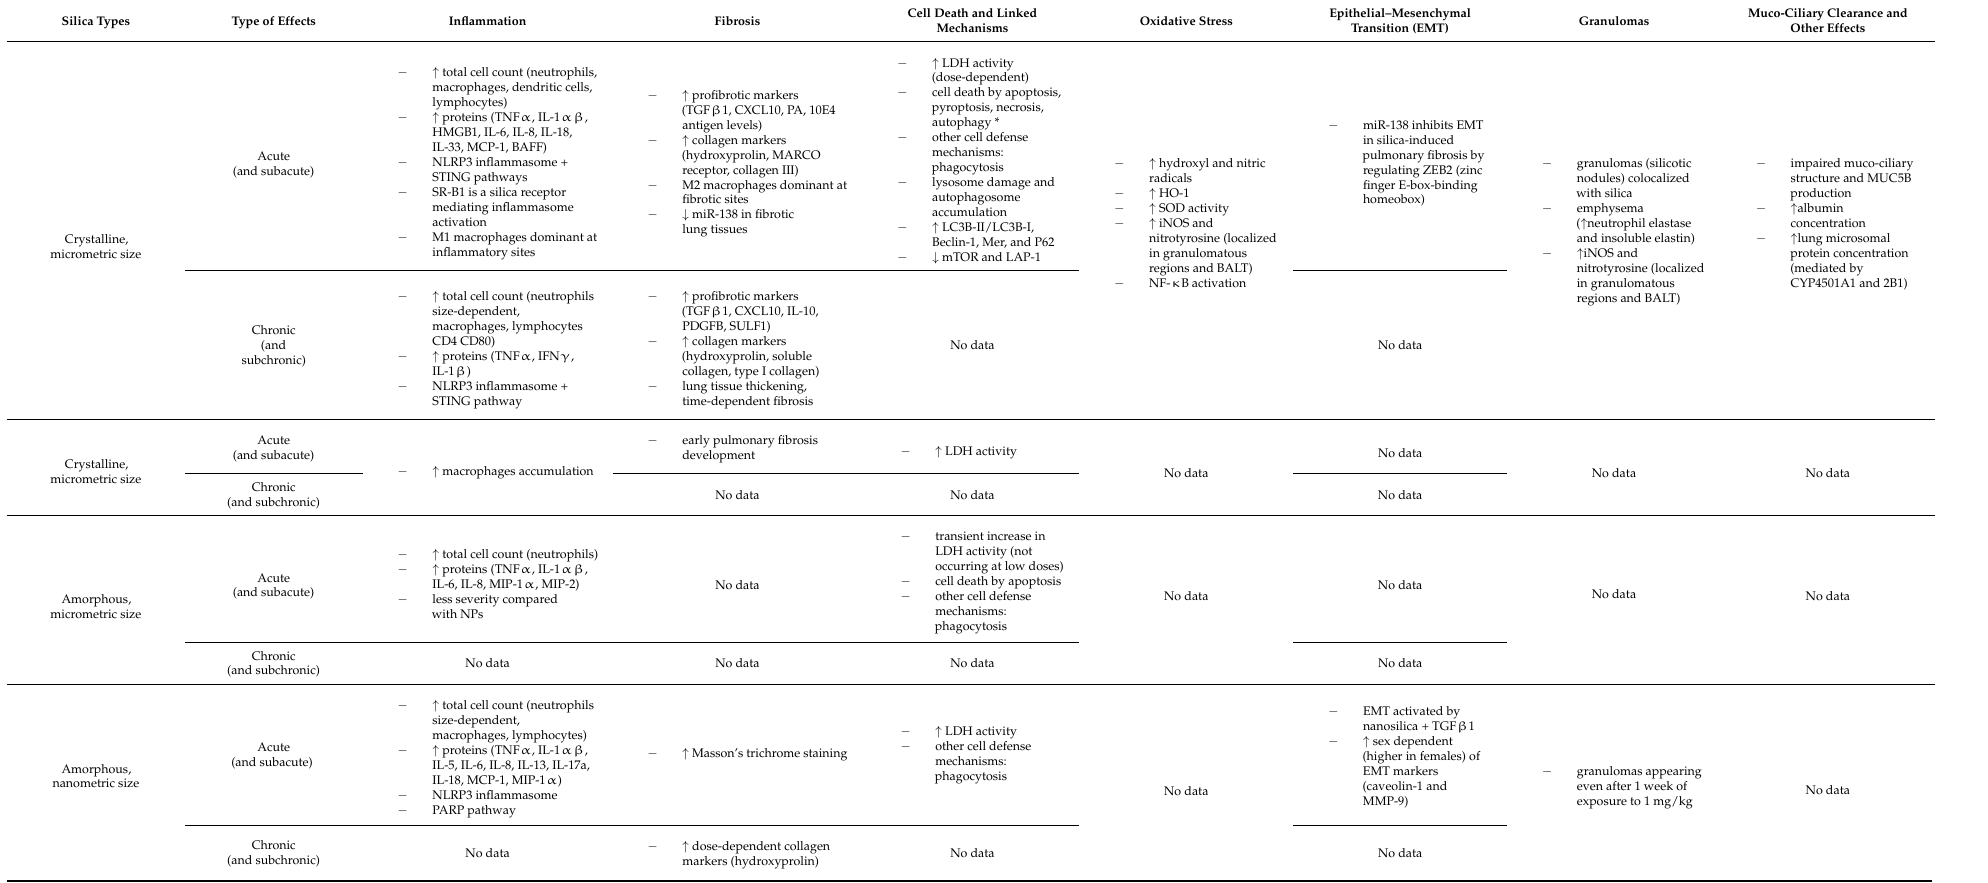
Table 1. Summary of results in vivo studies in mice and